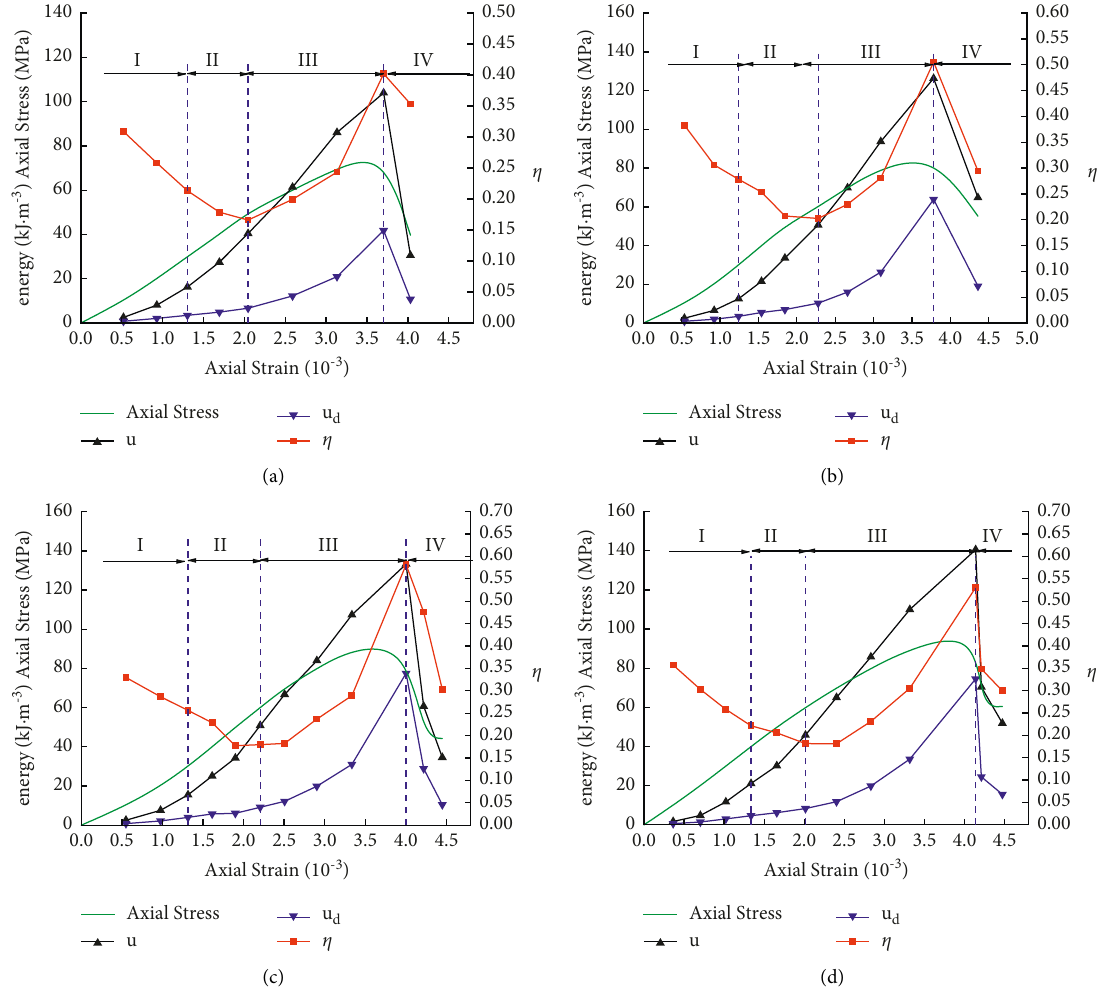
Figure 6: Axial stress-strain and energy evolution curves under cyclic loading and unloading. (a) σ � 20MPa. (d) σ � σ 3 3